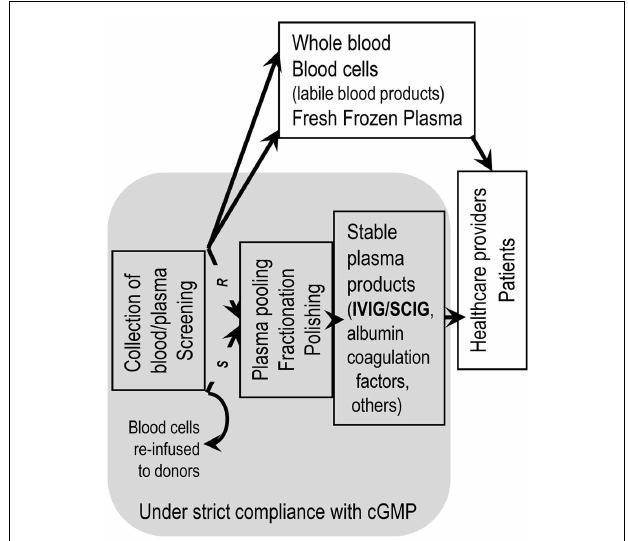
FIGURE 2 | Staying within a regulatory network is mandatory for remaining at the sunny side of the moon . Handling of blood/plasma products to obtain therapeutic goods has to be performed within a regulatory framework. Manufacturing of stable blood product has to adhere strictly to current good manufacturing practice (cGMP). Application of cGMP starts from the moment of collecting whole blood and isolation of plasma thereof (R = recovered plasma) or the machine-supported collection of plasma (S = source plasma, apheresis plasma). Application of cGMP ends at delivery of blood/plasma products to health care professionals. Not following cGMP can lead to withdrawal of a plasma product from the market from one to the other